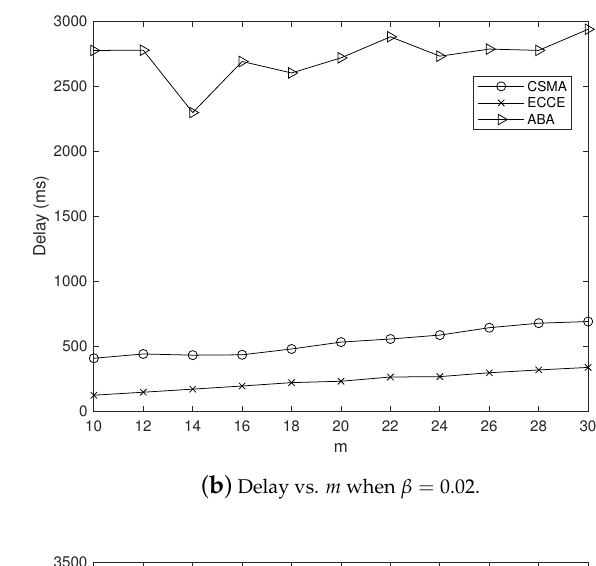
( a ) Delay vs. m when β = 0.01.